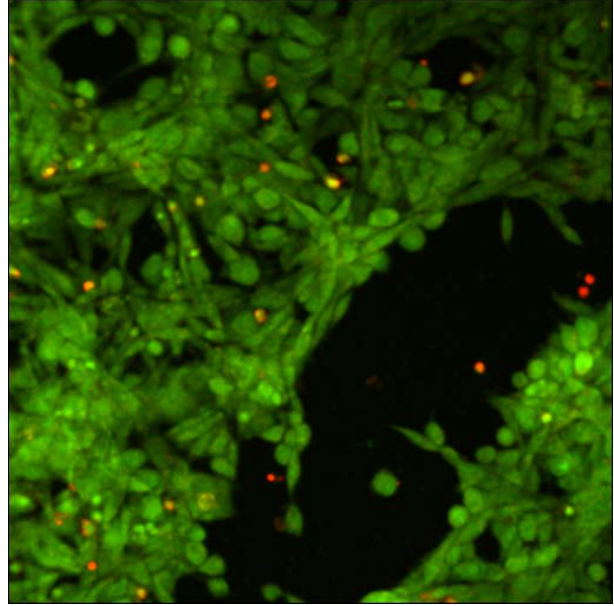
Figure 7. Laser scanning confocal microscopy image of “live - dead” viability test on NIH 3T3